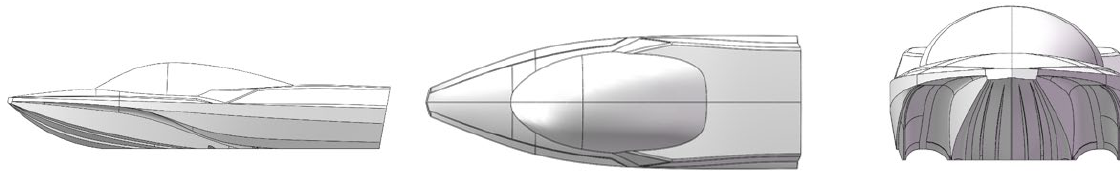
Figure 2. Three views of Model 0.